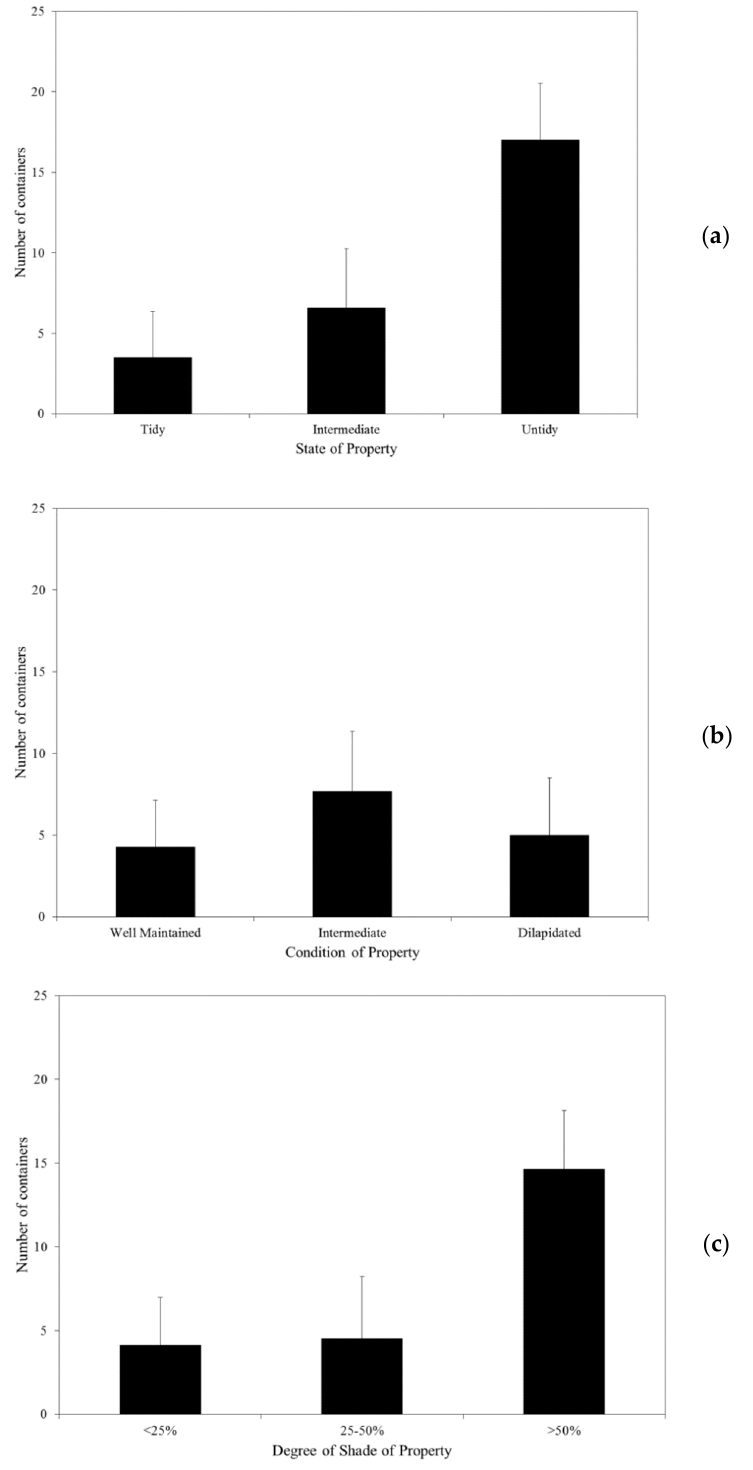
Figure 2. Comparison of mean number of containers per property according to state of property ( a ), condition of property ( b ), and degree of shade ( c ) in the suburb of Carrington, NSW.